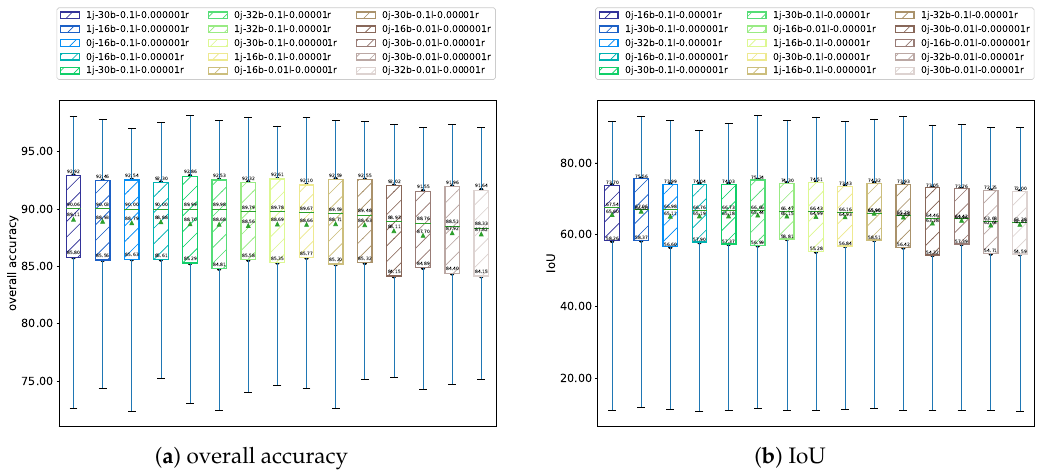
Figure 9. Segmentation satellite results on the World dataset (100 images): ( a ) is by using dlib’s measure—overall accuracy, ( b ) shows intersection over union (IoU). The bests model considering the medians (the mean is vulnerable to outliers) are for ( a ) 1j-30b-0.1l-0.000001r and for ( b ) 0j-16b-0.1l-0.00001r. The experiments were named according to the following naming convention: <jittering was used> j - <batch size> b - <initial learning rate> l - <minimum learning rate> r